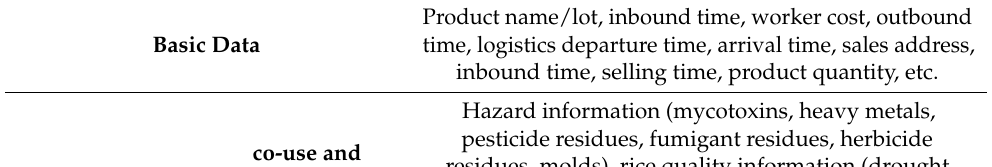
Table 2. Data analysis table of rice circulation